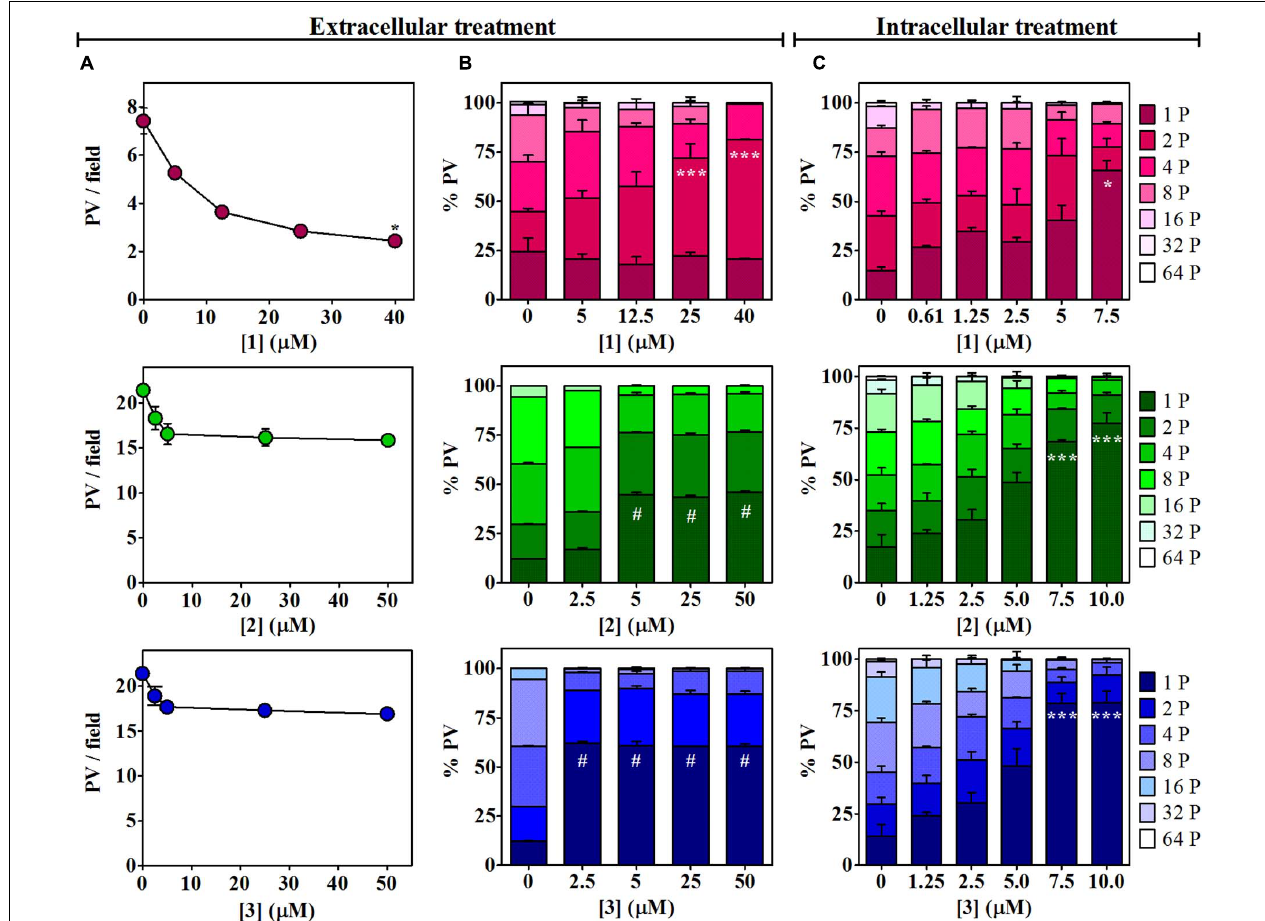
FIGURE 2 | Effects of 1 – 3 on Toxoplasma invasion and replication. (A) Invasion process. Extracellular tachyzoites, treated with different doses of β Cs or the vehicle (DMSO) for 1 h, were allowed to invade Vero cell monolayers. Data are presented as means of PV/field ± SEM. Graphs are representative of two independent experiments performed in duplicates. (B,C) Replication process. Percentage of PV with 1, 2, 4, 8, 16, 32, or 64 tachyzoites (from dark-colored to light-colored stacked bars) were obtained for (B) 1-h-pretreated parasites after 1 day of incubation and (C) intracellular tachyzoites after 2 days of incubation with different concentrations of the investigated β Cs or the vehicle. Results are expressed as means of % PV ± SEM obtained from two independent experiments performed in triplicates. Data were analyzed by Kruskal–Wallis/Dunn’s (asterisks) or ANOVA/Dunnett’s (hash symbols) tests. Marks indicate significant differences in PV/field or in % PV having one parasite [or two parasites for 1 in column (B) ] between treated samples and controls (* , # p < 0.05; *** p < 0.001). For 1 , results in columns (A,B) were previously published by Alomar et al. (2013) and were included here for comparative